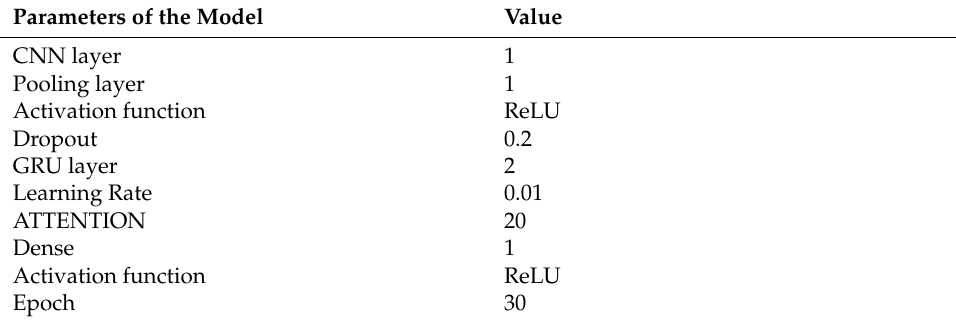
Table 10. Real Dataset Model